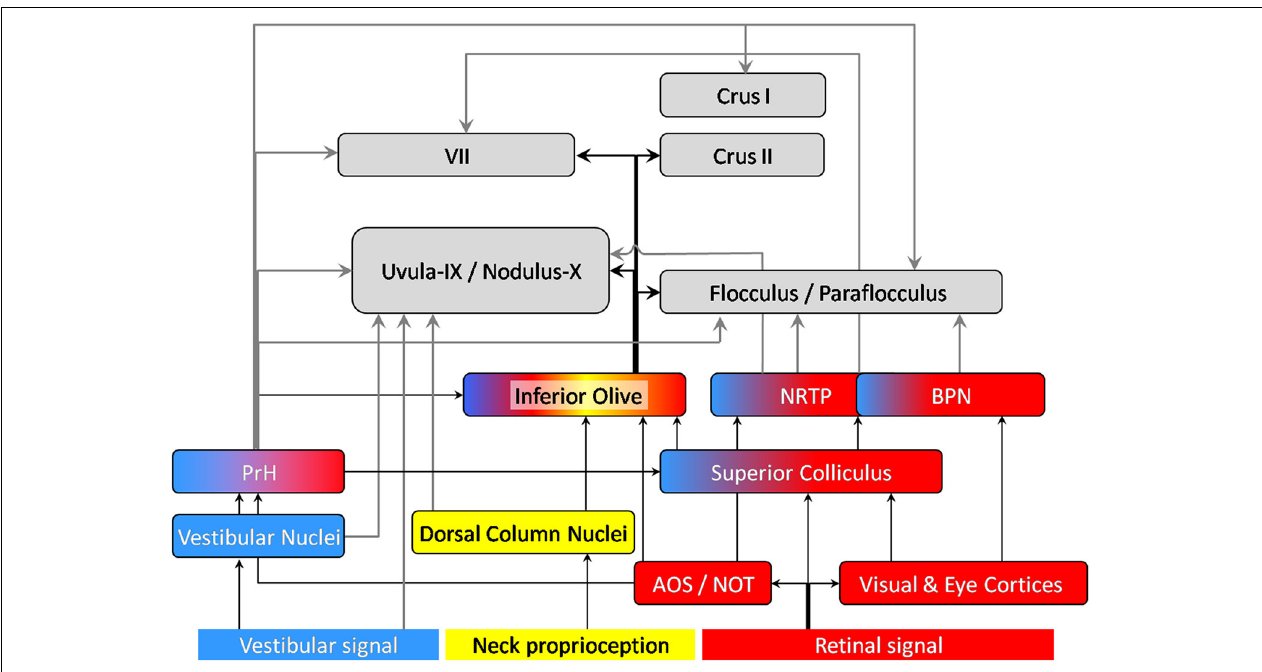
FIGURE 2 | Anatomical projections of visual (red), vestibular (blue) and neck proprioception (yellow) inputs to the cerebellar cortex. The displayed connections were found in rodents and/or rabbits. Arrows connecting the cerebellum are highlighted in bold: gray arrows correspond to mossy fibers, black ones to climbing fibers. AOS, Accessory Optic System;